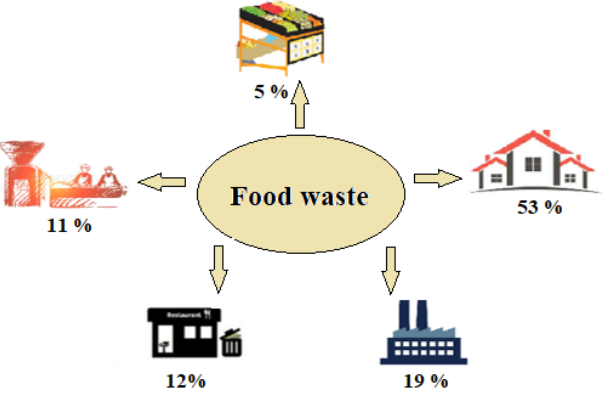
Figure 3. European Union Food Waste Generation (modified after